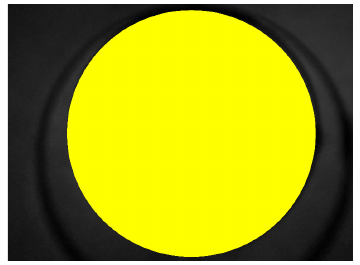
Figure 13. Region of interest detected using CHT.